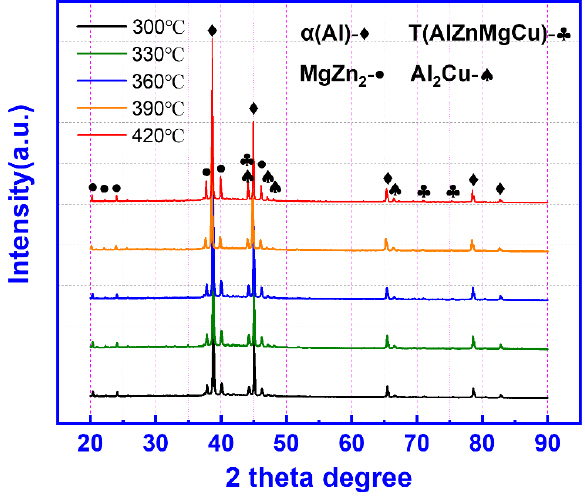
Figure 8. XRD patterns of the 13Zn alloy after hot